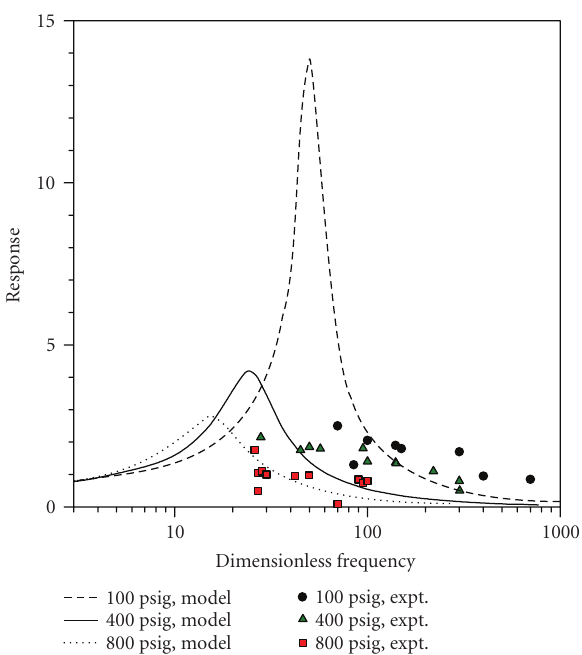
Figure 10: Frequency response of AP/HTPB Propellant D, theory ( K b = 140000 s − 1 , Δ H s = − 1 000000 J/kg) and experiment [24], in terms of real part of pressure-based function (theory and experi- ment, pressure at 200